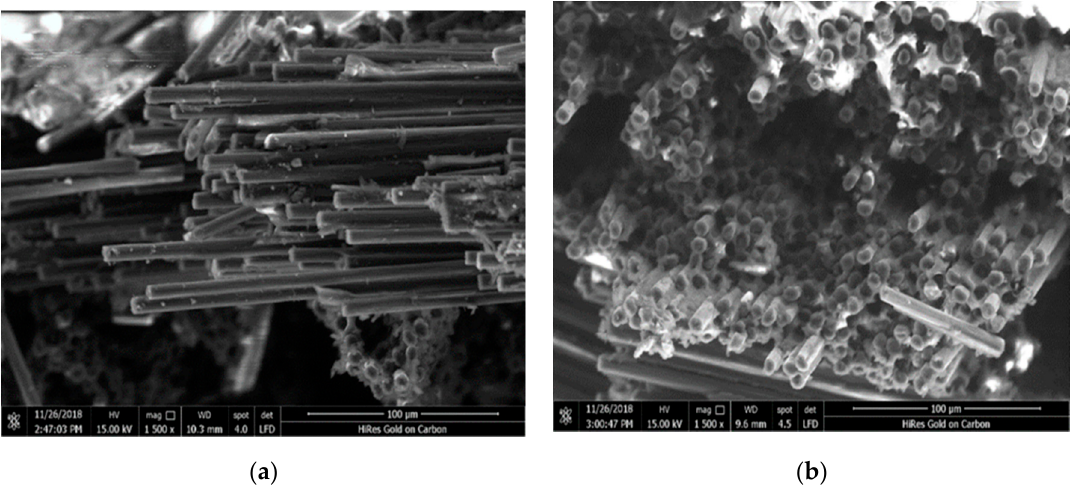
Figure 8. Scanning Electron Microscopy (SEM) micrographs of fracture surfaces of ( a ) composite-fiber epoxy resin sample and ( b ) nanocomposite-fiber sample.